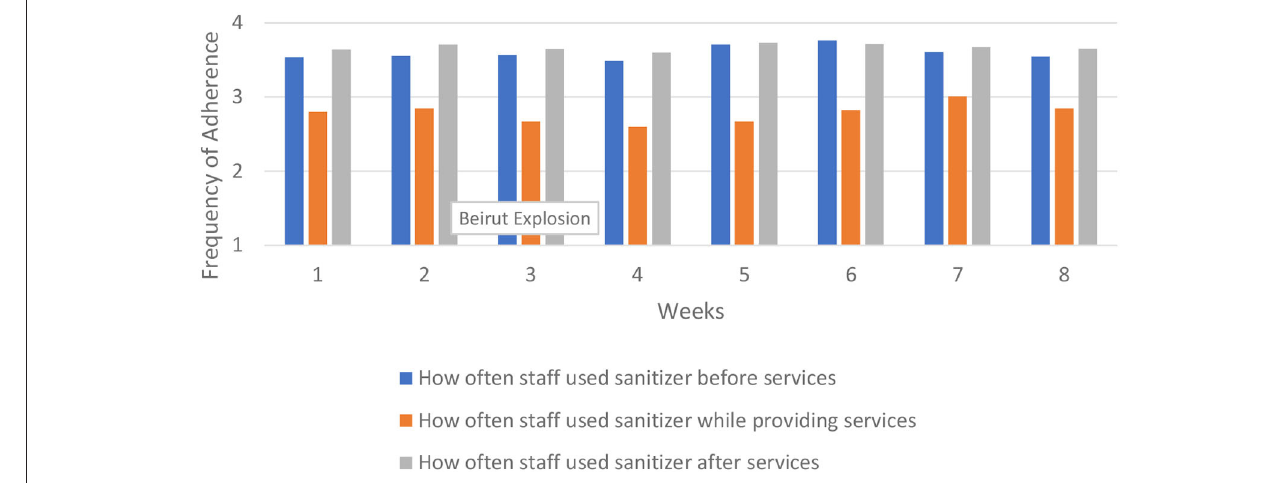
FIGURE 5 | Staff sanitizer use across region.